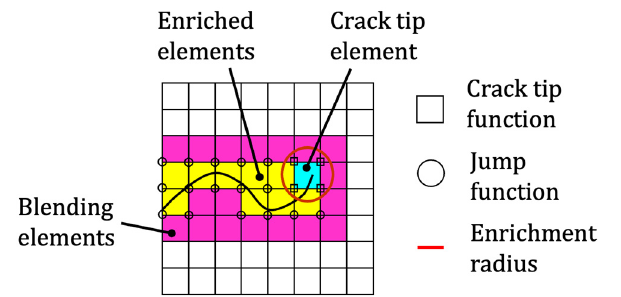
Figure 2. XFEM model 2D mesh with enhanced nodes and radius [25].